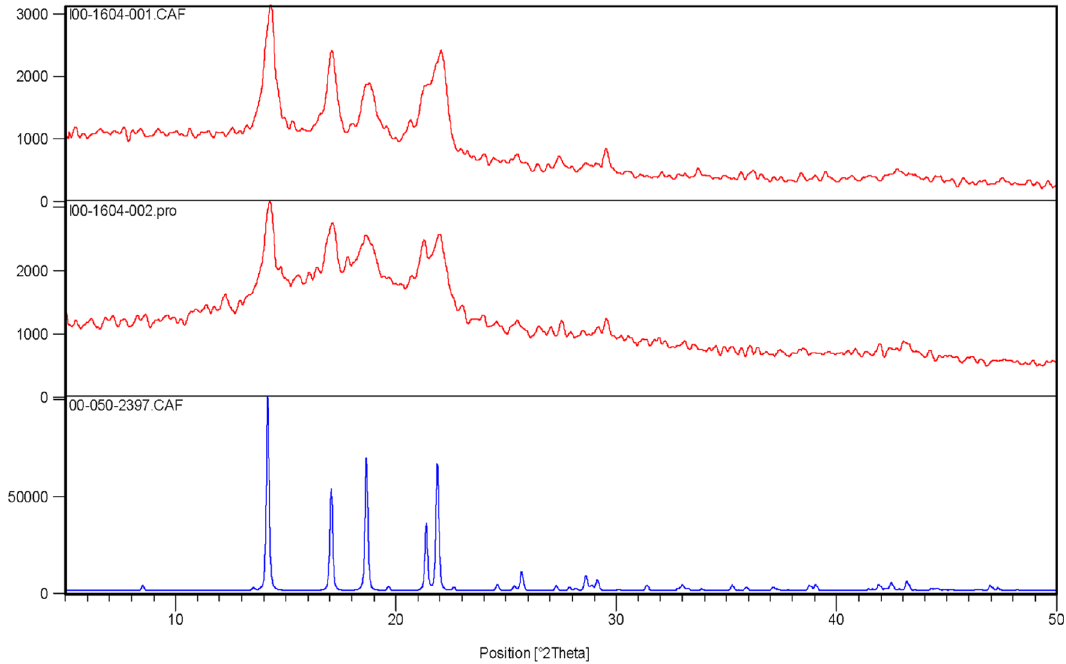
Figure 5. X-ray diffraction (XRD) patterns of PP-nonwoven fabric and amine group modified PP-g-(GMA-co-